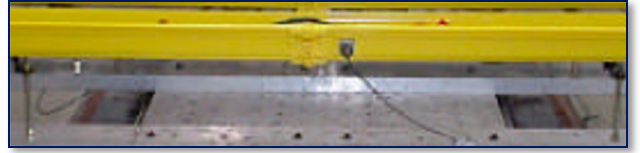
Figure 4. Component under testing.